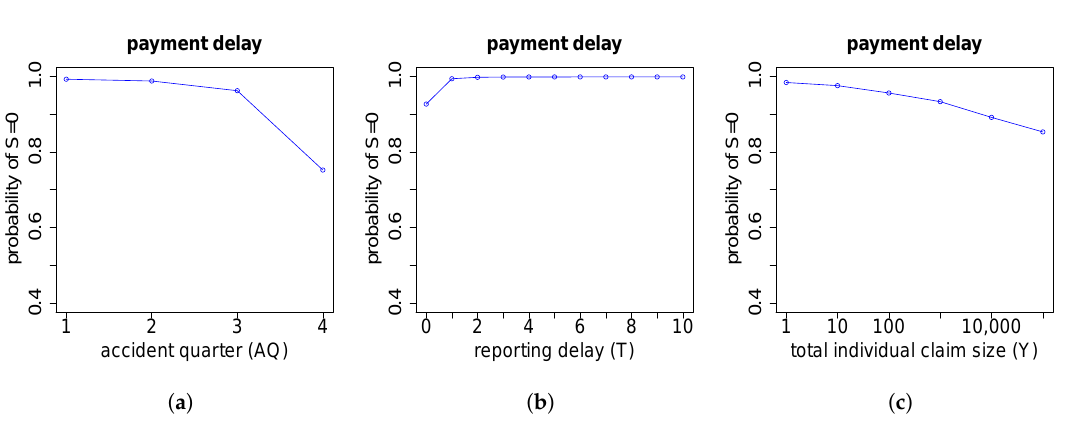
Figure A12. Indicator whether we have payment delay S = 0 or S > 0 in the case of K = 1 payment w.r.t. the features ( a ) AQ ; ( b ) reporting delay T and ( c ) total individual claim size Y .